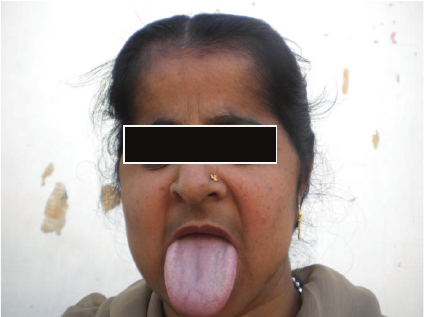
Figure 1: Patient with large protruding tongue.